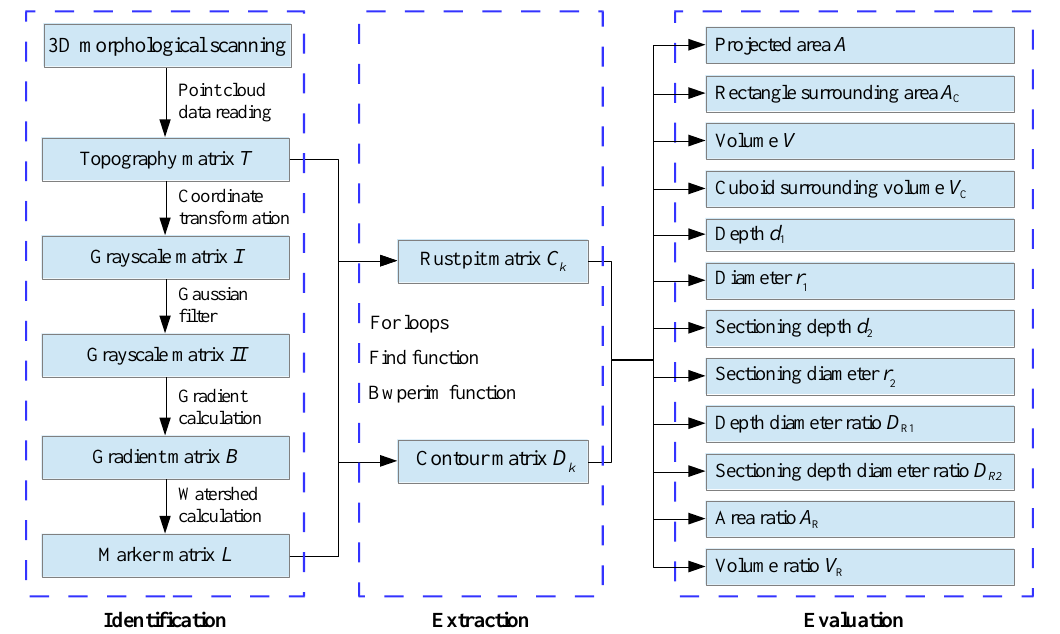
Figure 3. Program chart of identification, extraction, and evaluation of rust pits on the surfaces of corroded steel structures.